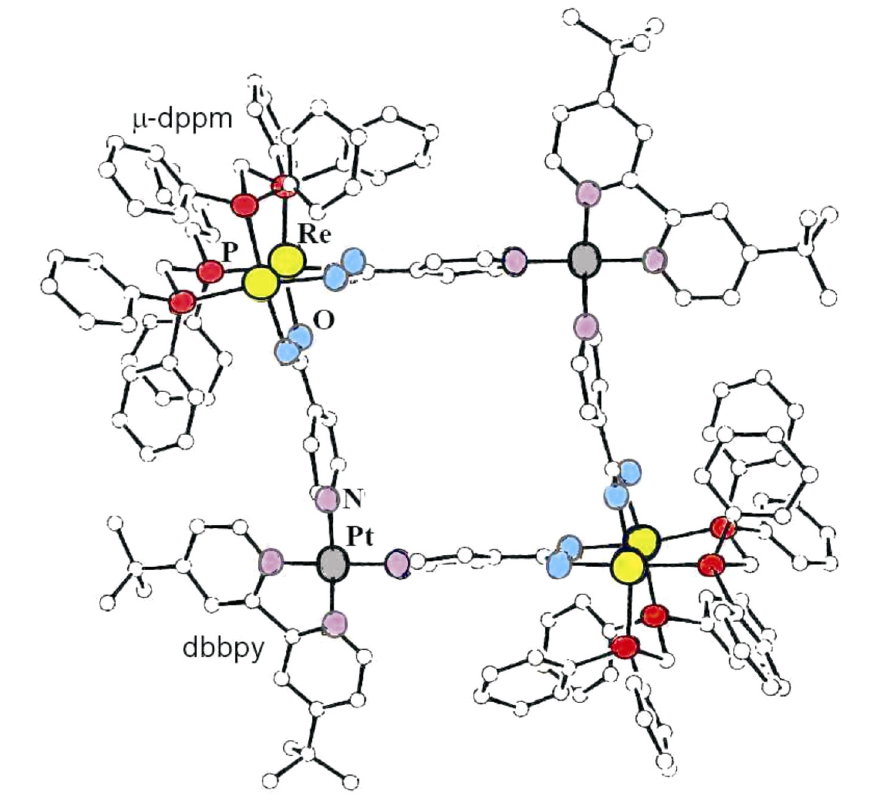
Figure 5. Structure of [(dbbpy)Pt(µ-pyc)